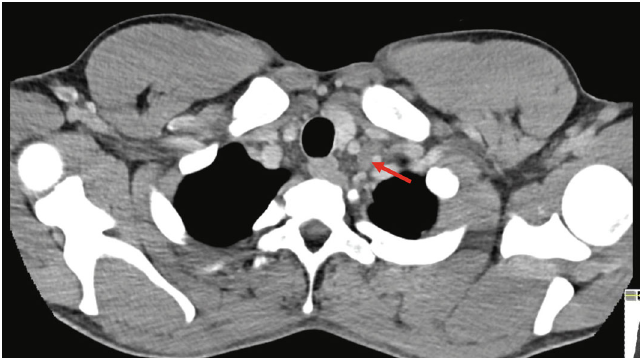
Figure 3: CT. Axial thoracic contrast-enhanced CT image at the thoracic inlet, showing a left supraclavicular lymphadenomegaly (red